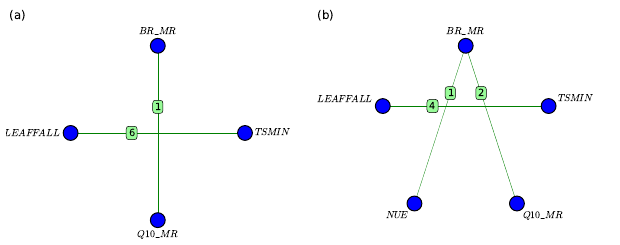
Figure 7. Relevant joint Sobol indices, S ij , corresponding to Octo- ber NEE averages for (a) D ST and (b) D TR . The labels on each line show the magnitude, in %, of Sobol indices for the corresponding parameter pairs.